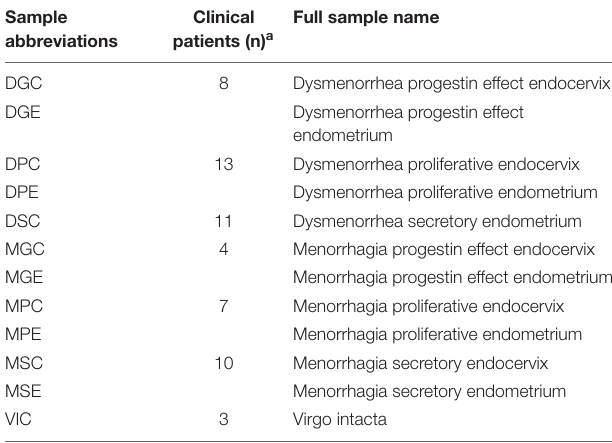
TABLE 1 | Sample abbreviations and clinical